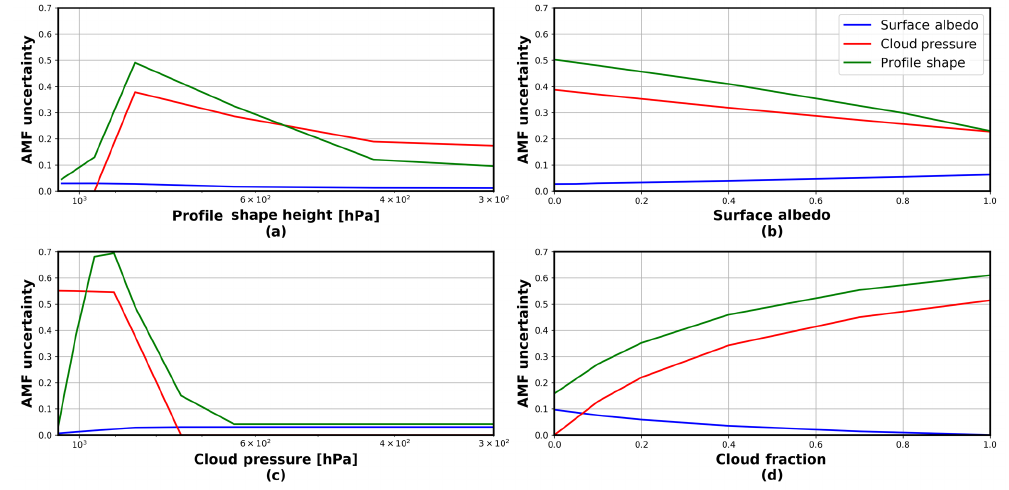
Figure 10. AMF uncertainty related to profile shape, cloud pressure, and surface albedo errors, as a function of different observation condi- tions. In all cases, we consider a nadir-viewing and a solar zenith angle of 30 ◦ . By default, fixed values have been used. The surface pressure is 1063hPa, the albedo is 0.05, the effective cloud fraction is 0.5, and the profile height and cloud pressure are